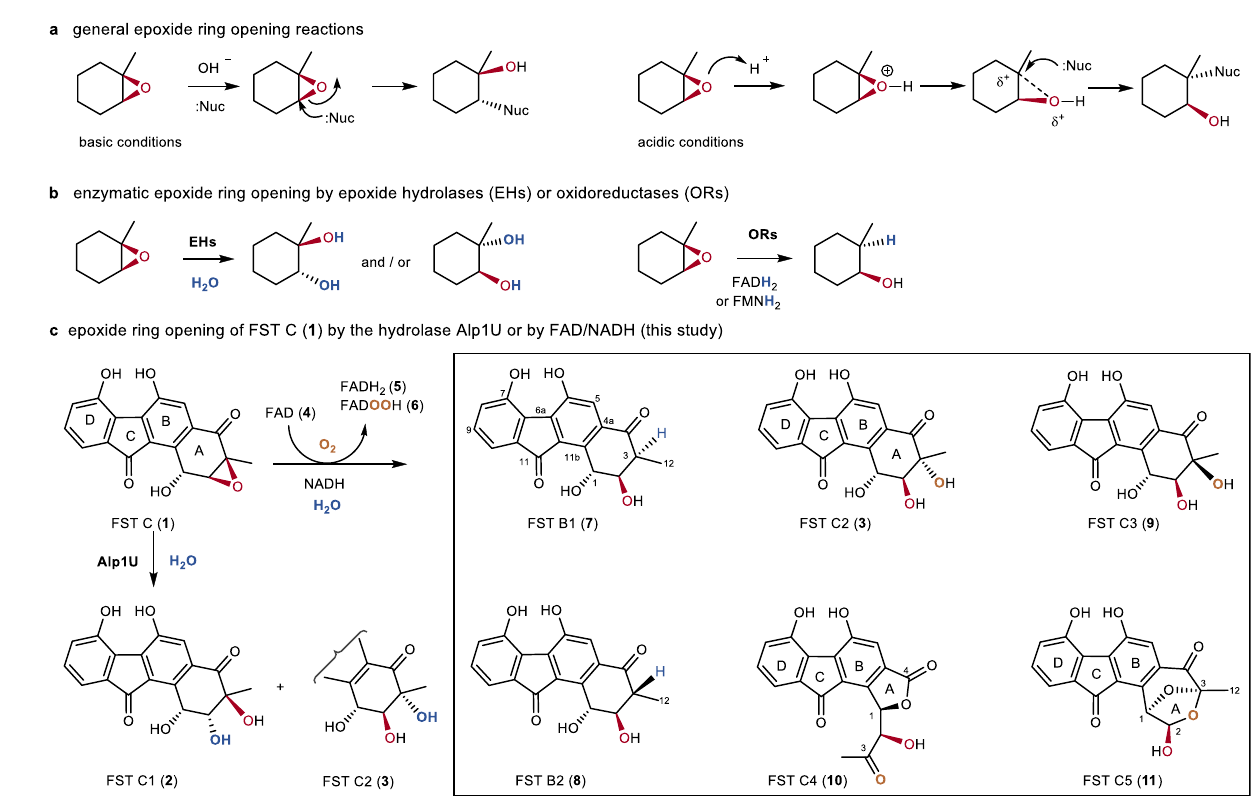
Fig.1|Representativeepoxidering-openingreactions.a Nonenzymaticepoxide ring-opening reactions involving addition of a nucleophile (Nuc) under basic or acidic conditions. b Enzymatic epoxide ring-opening reactions by epoxide